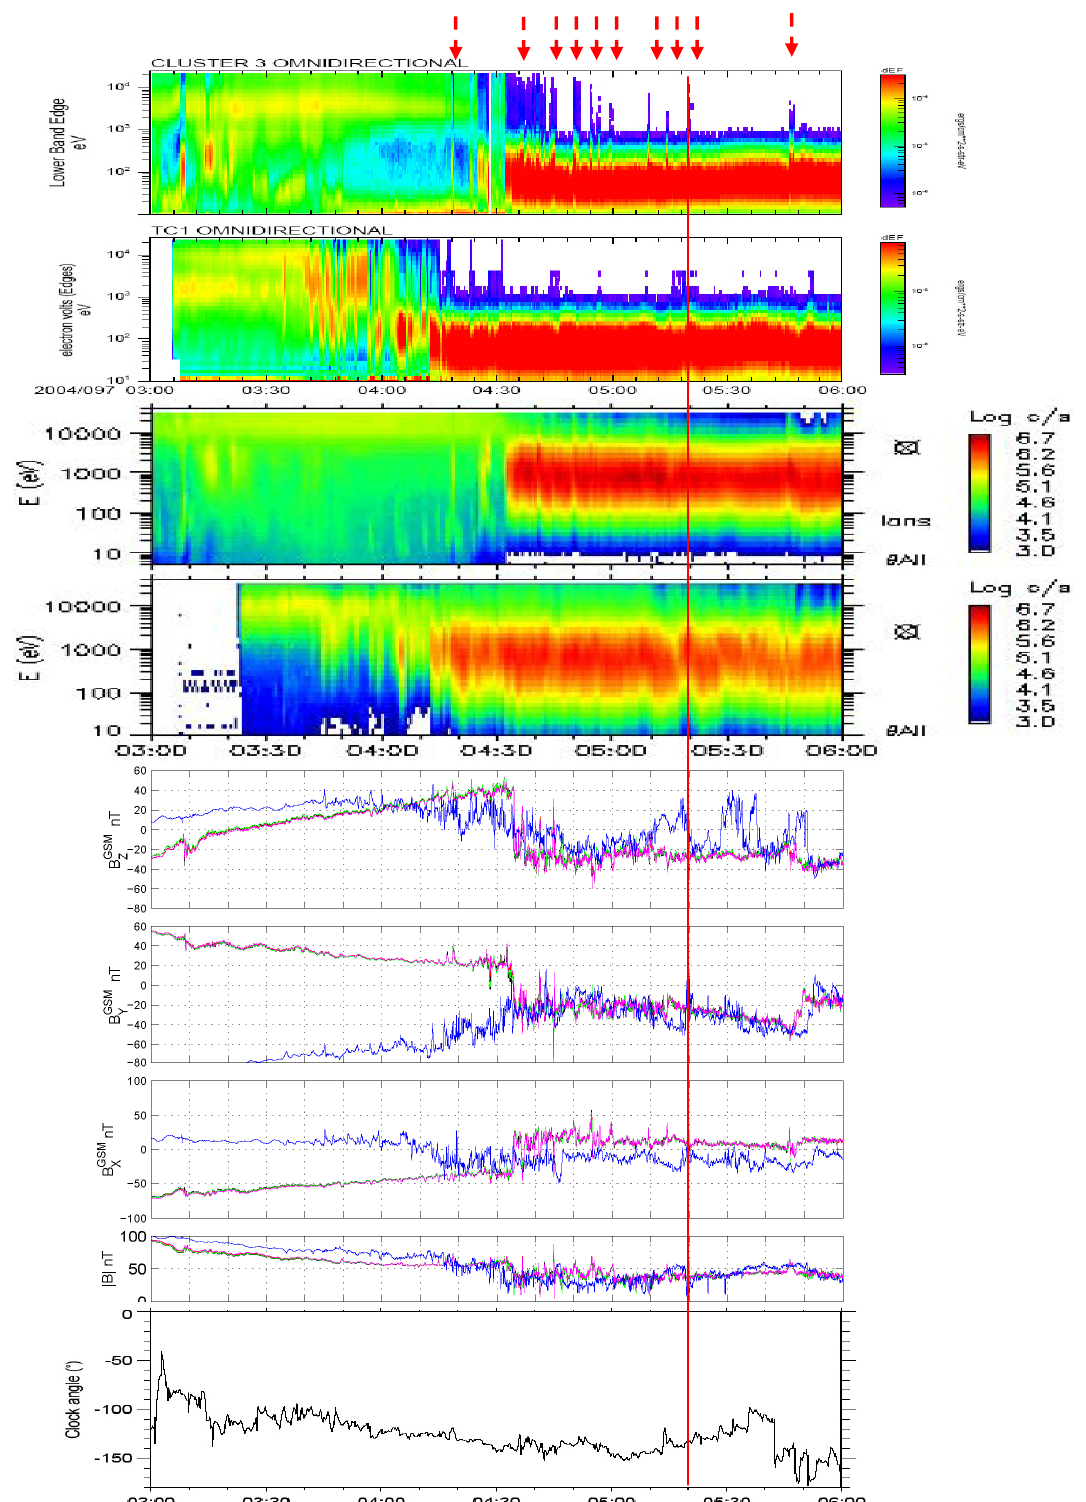
Fig 2 Fig. 2. Summary of the PEACE, HIA, and FGM measurements for the interval shown. The plots for PEACE and HIA are in the same format for Cluster 3 and TC-1, respectively, in both cases and show spin and pitch angle averaged, differential energy flux. The FGM plots show data from all four cluster spacecraft (1-black, 2-red, 3-green, 4-magenta) and TC-1 (in blue). A number of the FTE signatures are indicated by arrows at the top of the plot. The FTE discussed in the text is indicated also by the vertical red line (timed at Cluster). The lagged, IMF clock angle, obtained from ACE data, is shown in the bottom